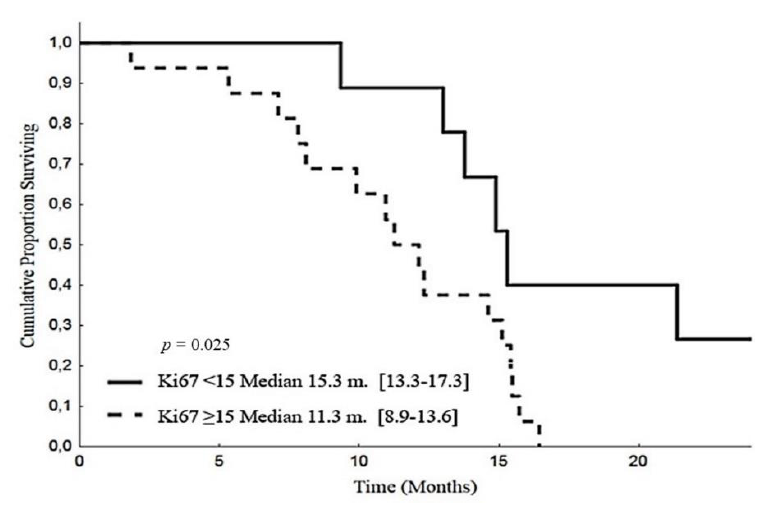
with a longer PFS than Ki67 expression below or equal the median value (15.1 months [95% CI: 14.5–